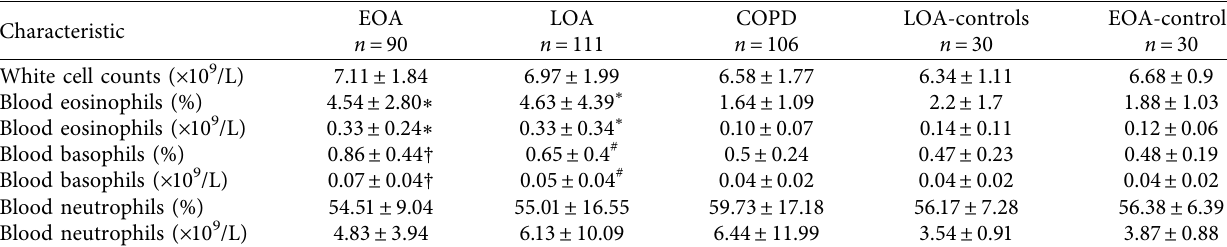
Figure 2: Lung function test and allergic features. (a) Spirometry results. # p < 0.01 EOA vs. LOA; ∗ p < 0.01 EOA and LOA vs. COPD. (b) The percentage of allergens. † p < 0.05 LOA vs. EOA and COPD; ‡ p < 0.01 EOA vs. COPD. (c) Reversibility for Table 2: Blood cells count data of participants.